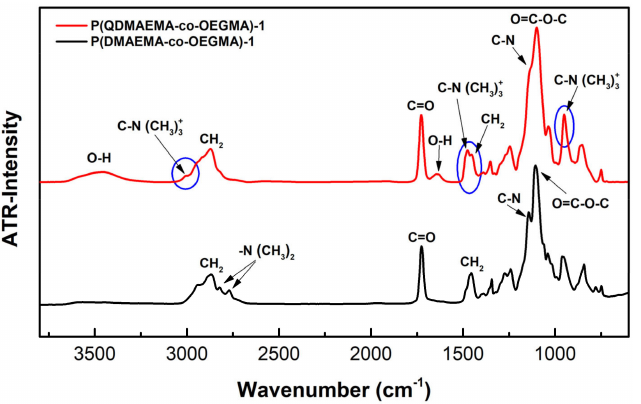
Figure 3. Representative ATR-FTIR spectra of P(DMAEMA-co-OEGMA)-1 and P(QDMAEMA-co- OEGMA)-1 copolymers in solid